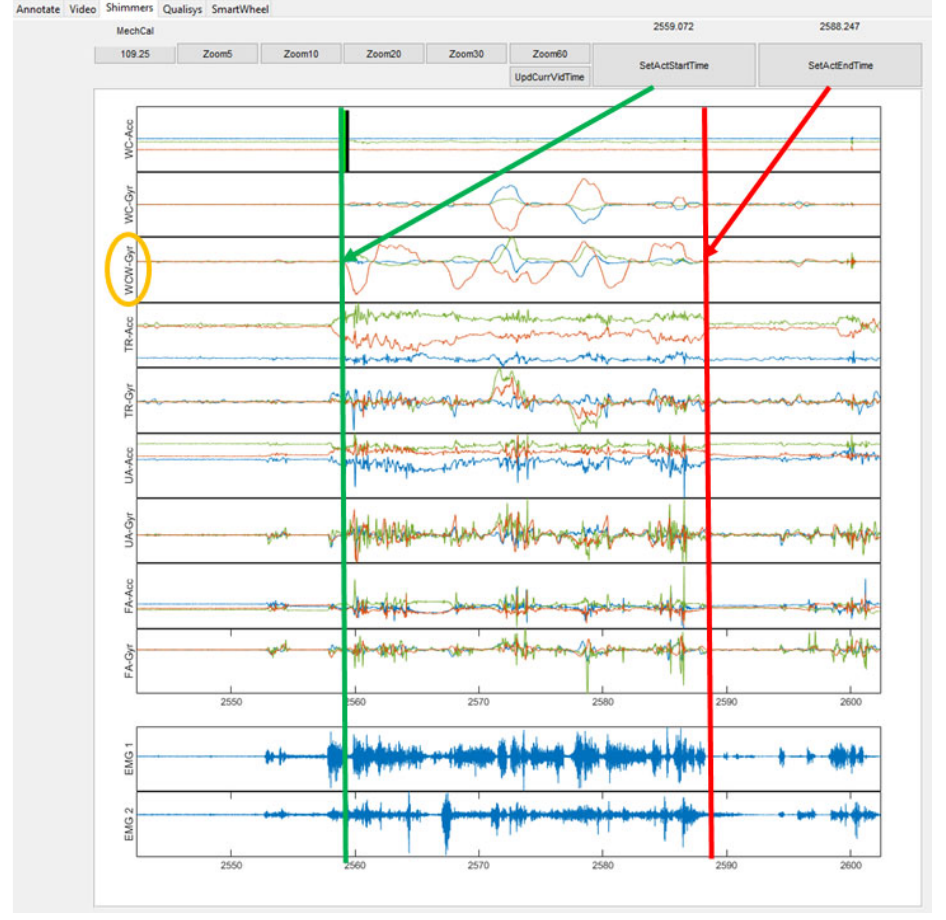
Figure 2. The video annotation of the start (green vertical line) and end (red vertical line) of the activity “Dribbling”; the gyroscope signal (yellow oval) from the wheel sensor was used to identify start and end of wheel rotation.